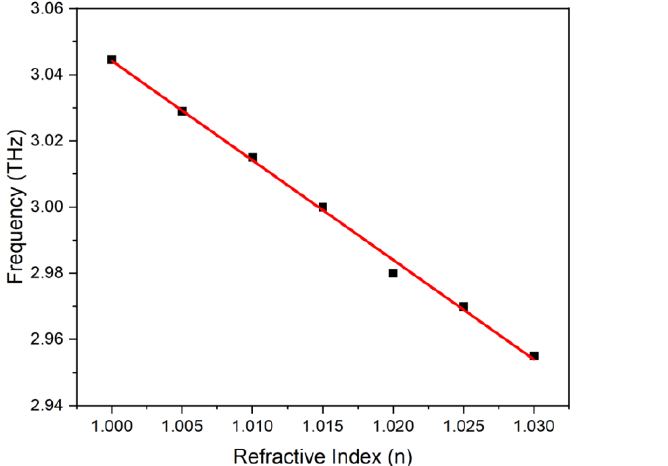
Figure 16. The position of the peak as a function of the refractive index of the surrounding